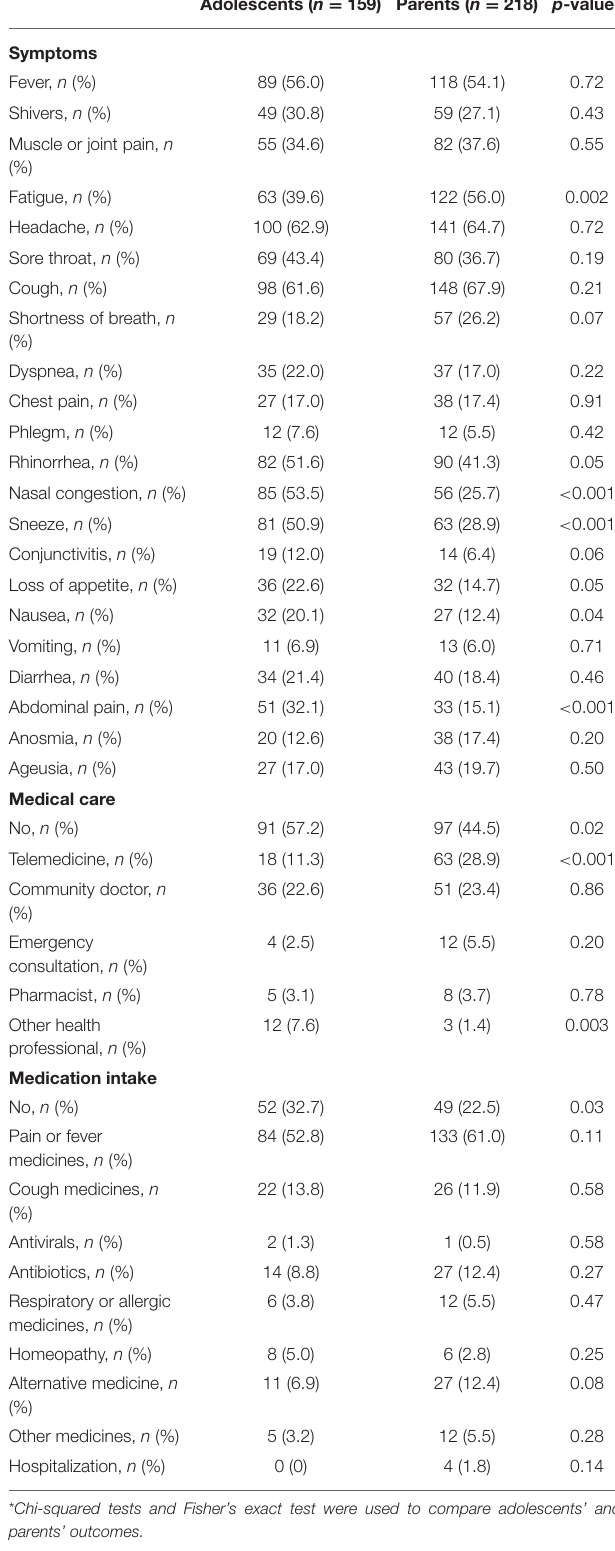
TABLE 3 | Comparison of clinical characteristics and medical care between TABLE 2 | Comparison of prevalence and incidence rates of COVID-19 outcomes adolescents and parents with possible COVID-19 in the PARIS birth cohort. between adolescents and parents in the PARIS birth cohort. p -value* Adolescents Parents Adolescents ( n = 159) Parents ( n = 218) p ( n = 832) ( n = 936)